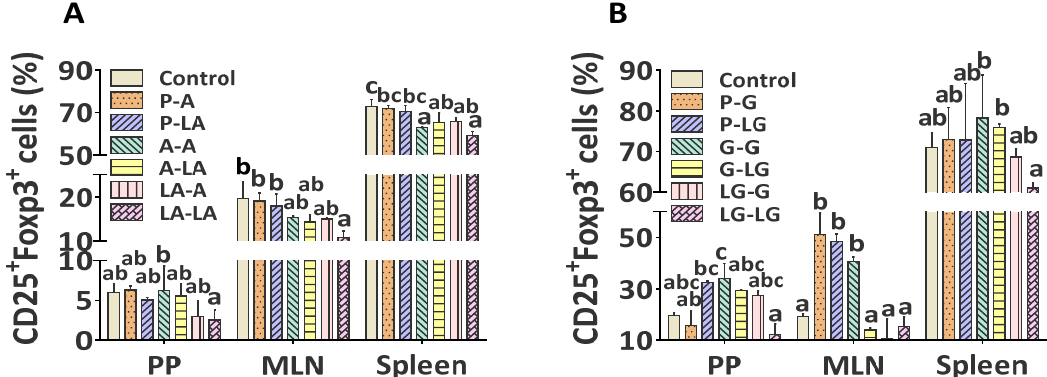
Figure 7. Regulatory T cells (Tregs) identification in spleen, Peyer’s patches (PP), and mesenteric lymph nodes (MLN). Percentages of CD25 + Foxp3 + cells in spleen, PP, and MLN tissues of BLA ( A ) and BLG ( B ) groups. Data were expressed as means ± SEM of four independent mice. The results are representative of two independent experiments. Statistical significance was determined by two-way ANOVA, followed by Tukey’s multiple comparisons test. The groups without the same letter in the histogram bar have statistical differences ( p < 0.05).